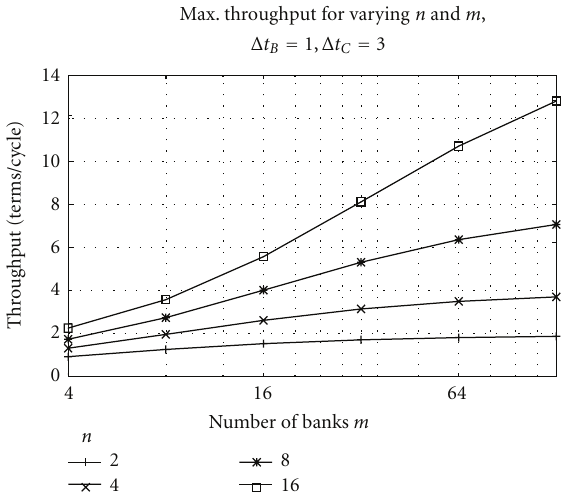
Figure 7: Best case (0 hits) average access time for a Bloom filter with m banks and n access ports, Δ t B = 1, Δ t C =